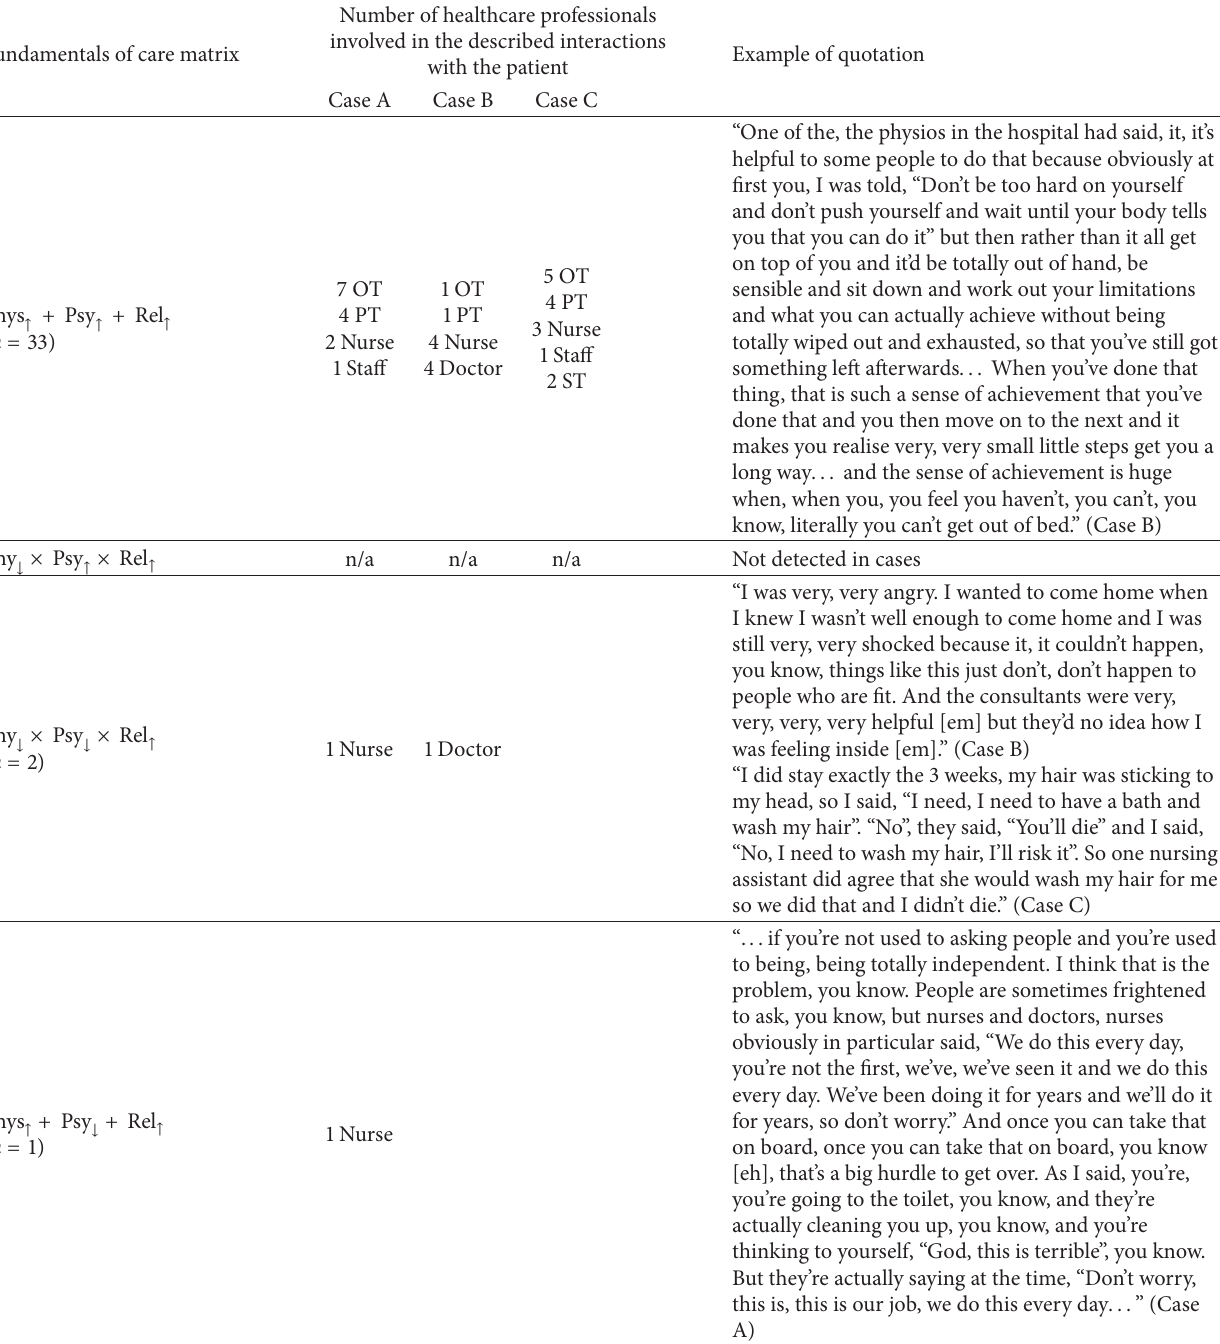
Fundamentals of care